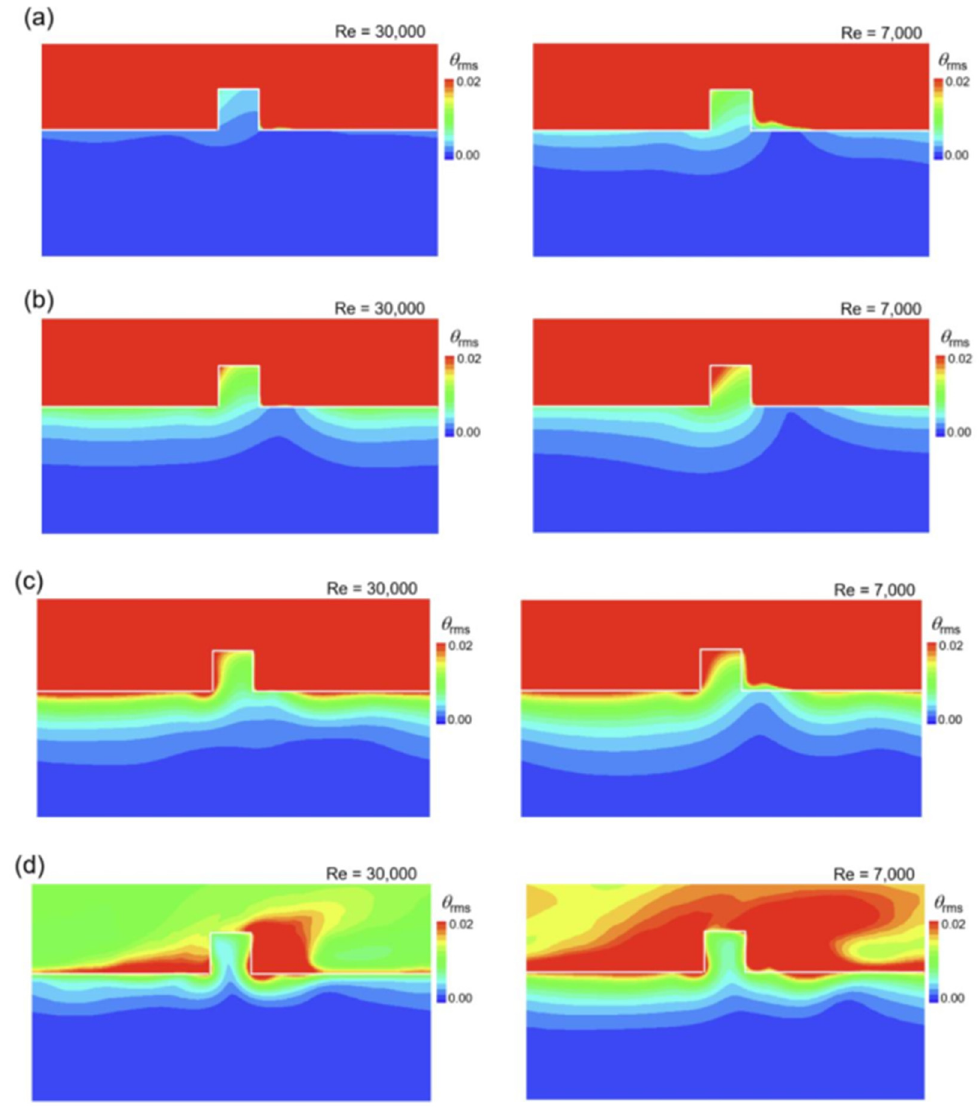
Figure 9. Temperature fluctuation contours for ( a ) K * = 566.26, ( b ) K * = 100.00, ( c ) K * = 10.00, and ( d ) K * = 1.00.